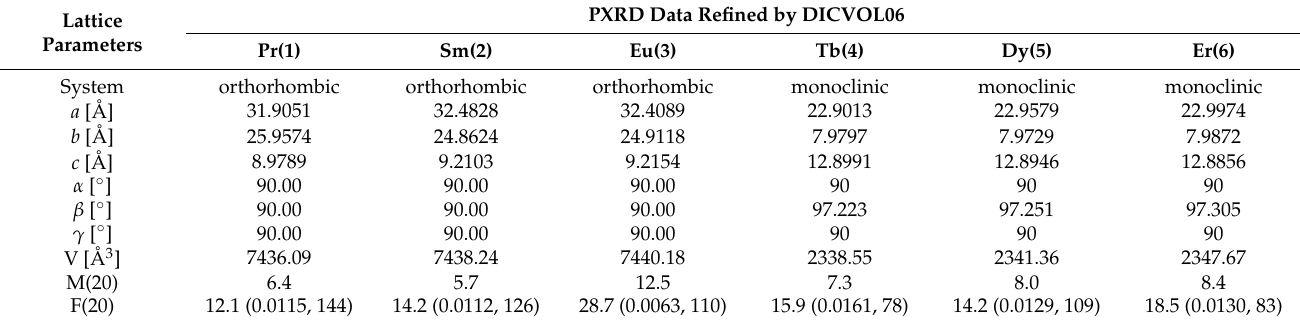
Table 2. Lattice parameters for polycrystalline forms of lanthanide(III) complexes.